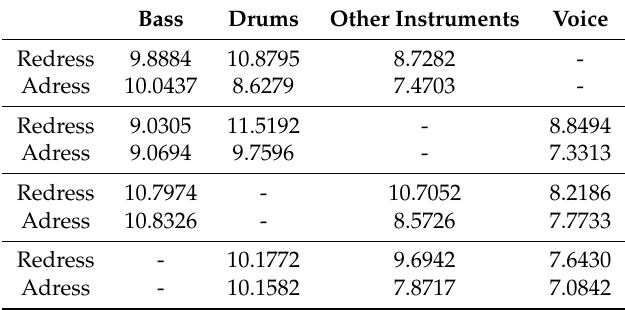
Table 2. Av. SNR (dB) of the source estimates: 3-source